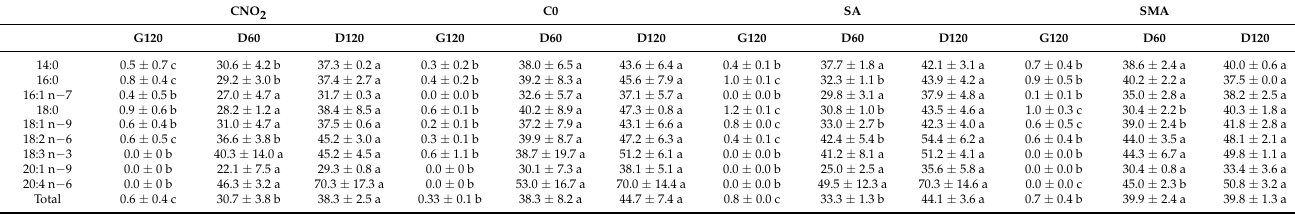
Table 1. Time-course of fatty acid bioaccessibility in the different salami formulations. Data are means ± SD of in vitro digestion of three independent samples analyzed in duplicate. Fatty acid bioaccessibility is expressed as a percentage, and it was calculated as the concentration of fatty acid methyl ester in digested salami/concentration in salami before digestion × 100. Statistical analysis was by one-way ANOVA (always p < 0.05) with Tukey’s post-hoc test comparing each salami formulation at the three digestion time points (different letters indicate statistical significance). G120: end of gastric phase; D60: mid duodenal phase; D120: end of duodenal phase; C-NO 2 : salami with sodium nitrite, potassium nitrate and with nitrate-reducing microbial starter cultures; C-0: salami containing neither nitrate-reducing microbial starter cultures nor additives (nitrite, polyphenols and ascorbate); SA: salami with nitrate-reducing microbial starter cultures and sodium ascorbate; SMA: salami with nitrate-reducing microbial starter cultures, sodium ascorbate and plant